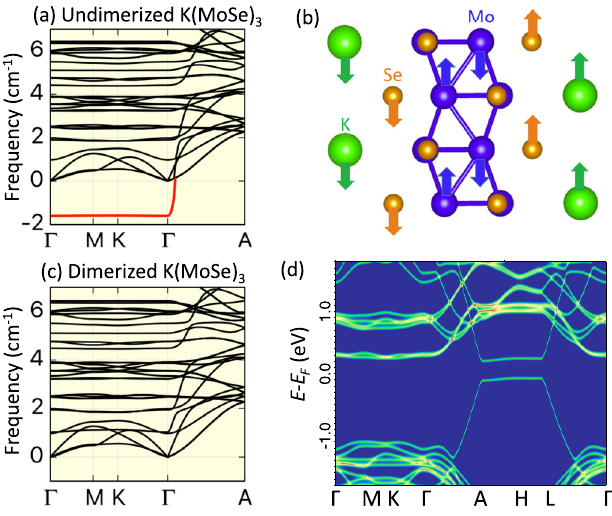
FIG. 4. Calculated phonon spectrum of undistorted K ð MoSe Þ 3 . The red phonon dispersion indicates soft phonon modes. (b) Vibration modes of the soft phonon at the Γ point in (a). (c) Calculated phonon spectrum of K ð MoSe Þ 3 under Peierls dis- tortion with the soft mode eliminated. (d) Band dispersion of distorted K ð MoSe Þ 3 showing a band gap throughout the k plane